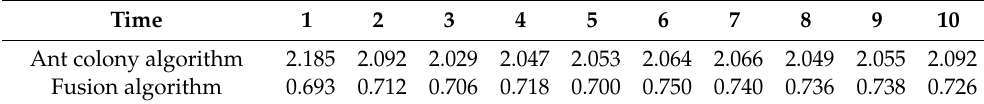
Figure 17. Ant colony algorithm path planning. Table 5. Comparison of path-planning time based on Figures 11b and 17b (unit: